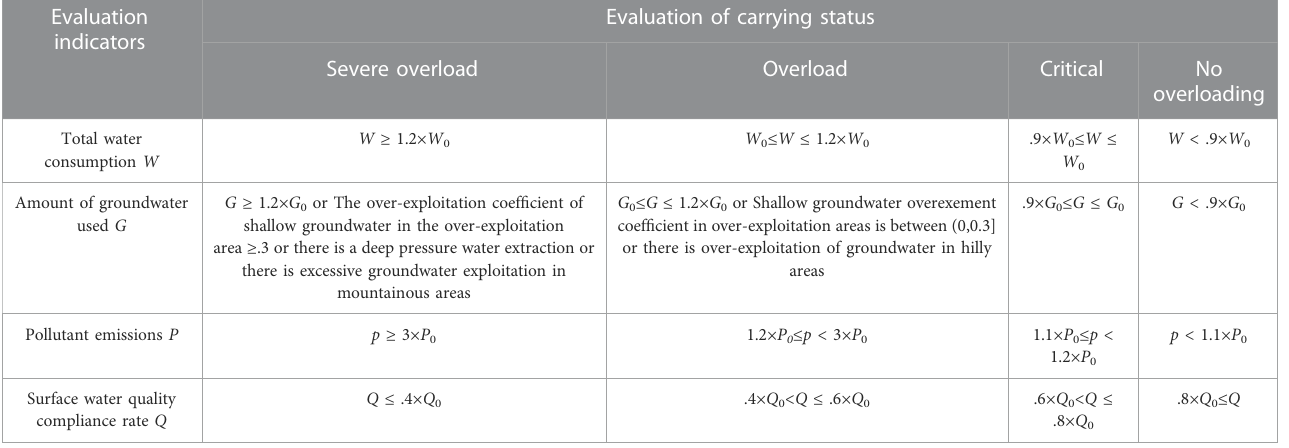
TABLE 1 Evaluation level threshold of one-factor evaluation method for water resource carrying capacity in Chicheng County.